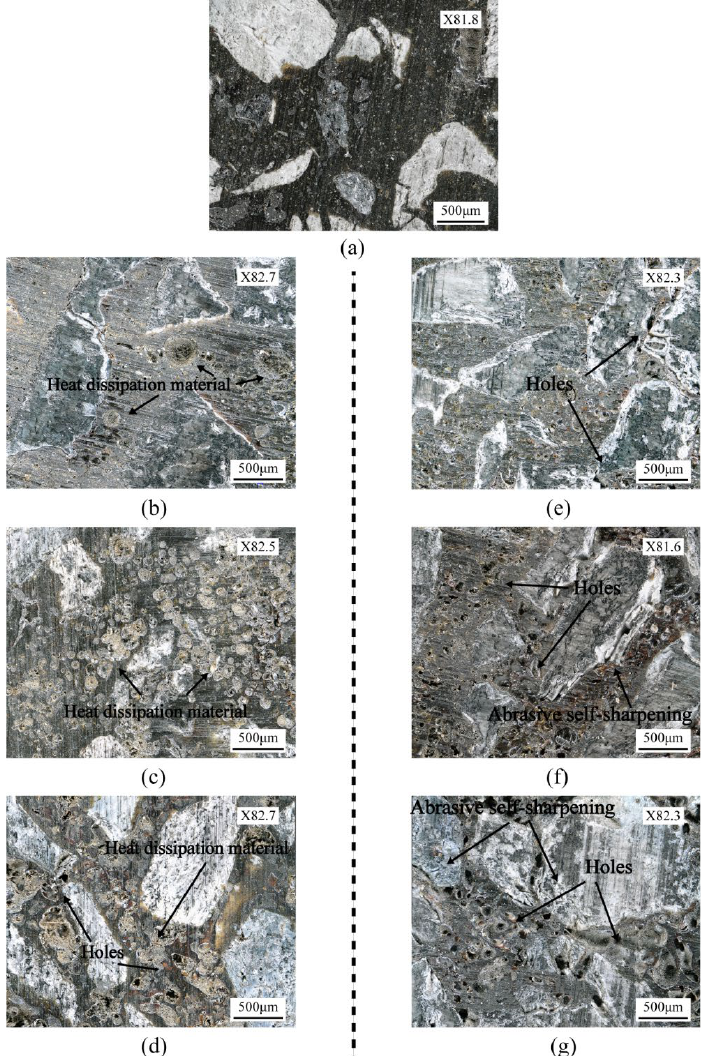
Figure 9. The surface of grinding wheel samples: ( a ) before grinding; ( b ) after the first pass of 10 s passive grinding (B 1 ); ( c ) after the second pass of 10 s passive grinding (B 2 ); ( d ) after the third pass